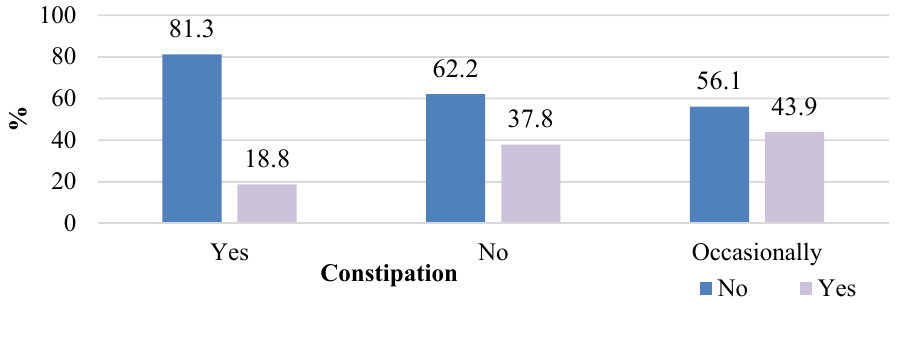
Fig. 6. Coffee and tea consumption by the respondents (p=0.036), n=250